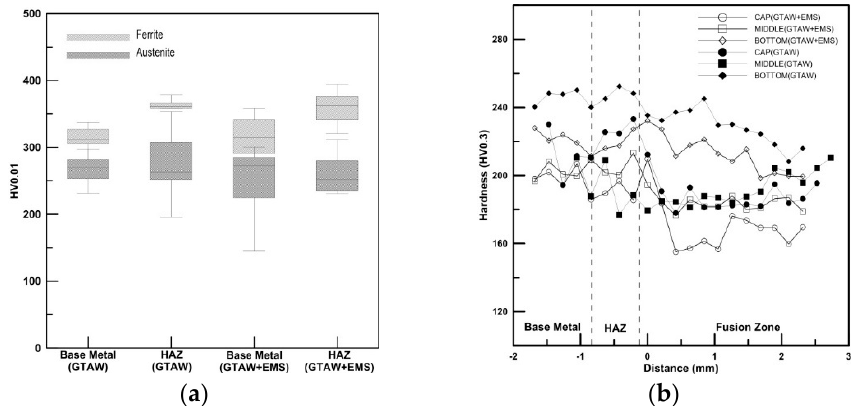
Figure 13. The results of the micro-hardness test: ( a ) the hardness measurements of the ferrites and austenites in the base metals and HAZs, and ( b ) the hardness profiles for the welds.